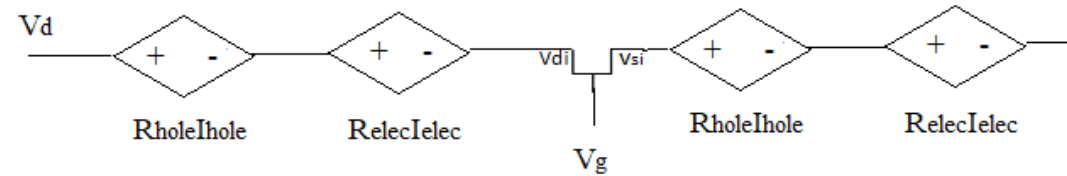
Figure 3. A phenomenological AVS circuit model.